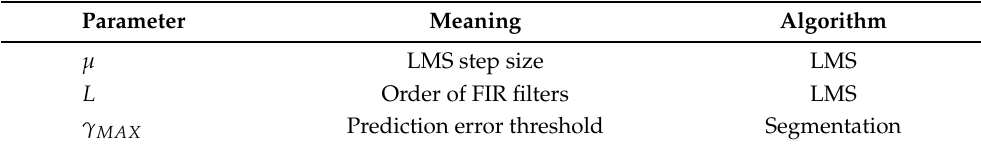
Table 3. Free parameters to be optimized.